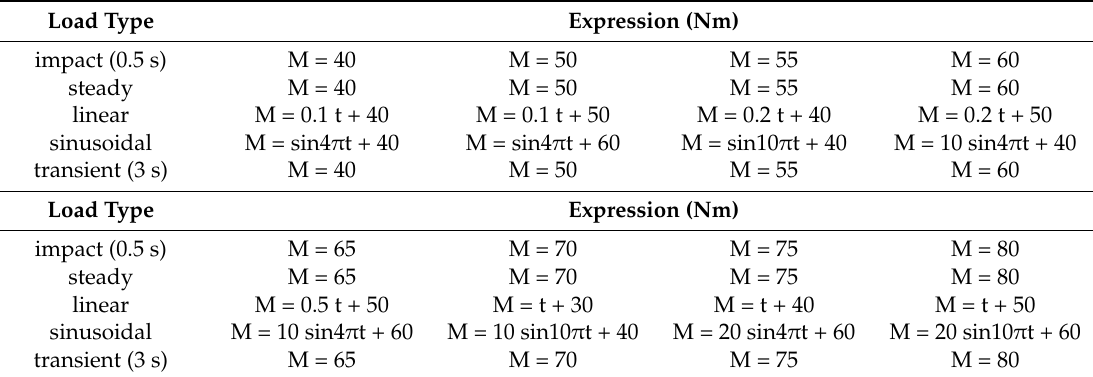
Table 2. Loads in rotor-system